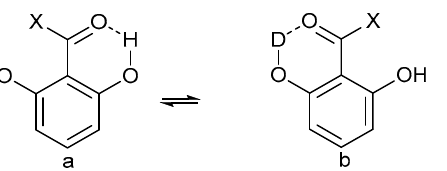
8 of 20 Figure 12. High-frequency part of the 1 H NMR spectrum of partially deuterated (OH/OD, 57%D) of a mixture of diphenylphosphoric and dimethylphospinic acid in CDF 3 /CDF 2 Cl at 100 K. Trimers are marked with asterisks and dimers with diamonds. Reprinted from Ref. [32]. 3.5. Miscellaneous The equilibrium in the system shown in Figure 13 was originally determined using